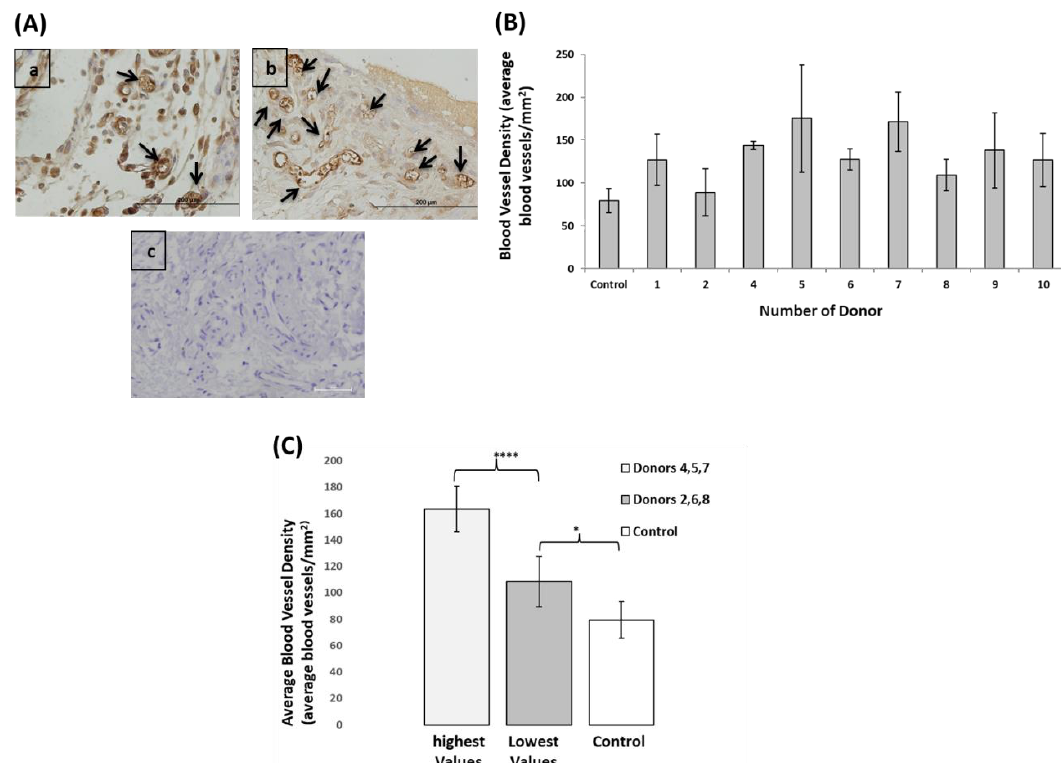
Figure 6. In-vivo angiogenic potential of EPCs ( A ) Histological analysis of EPCs subcutaneous transplantations. CD31 anti-mouse staining of in-vivo subcutaneous transplantation β -TCP sca ff old ( a ) without cells for control ( b ) with human EPCs ( c ) secondary antibody control. Functional blood vessels are indicated by a black arrow. ( B ) Blood vessel density in the subcutaneous implants. ( C )Comparisonbetweendonorswithhighvs. lowbloodvesseldensitiesrelativetocontrol**** p < 0.0001 and * p < 0.05,